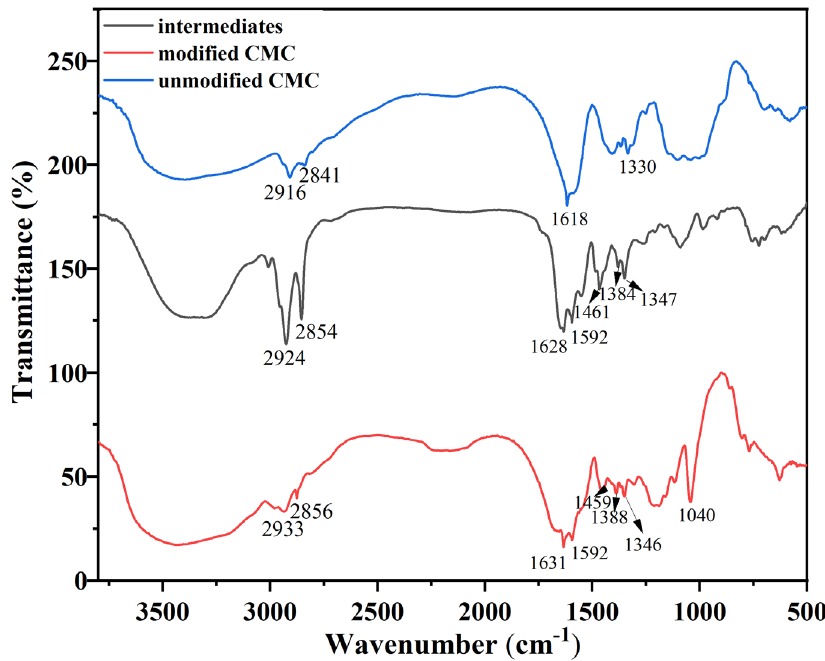
Figure 6. Infrared spectrum of the intermediates: CMC before and after modification.